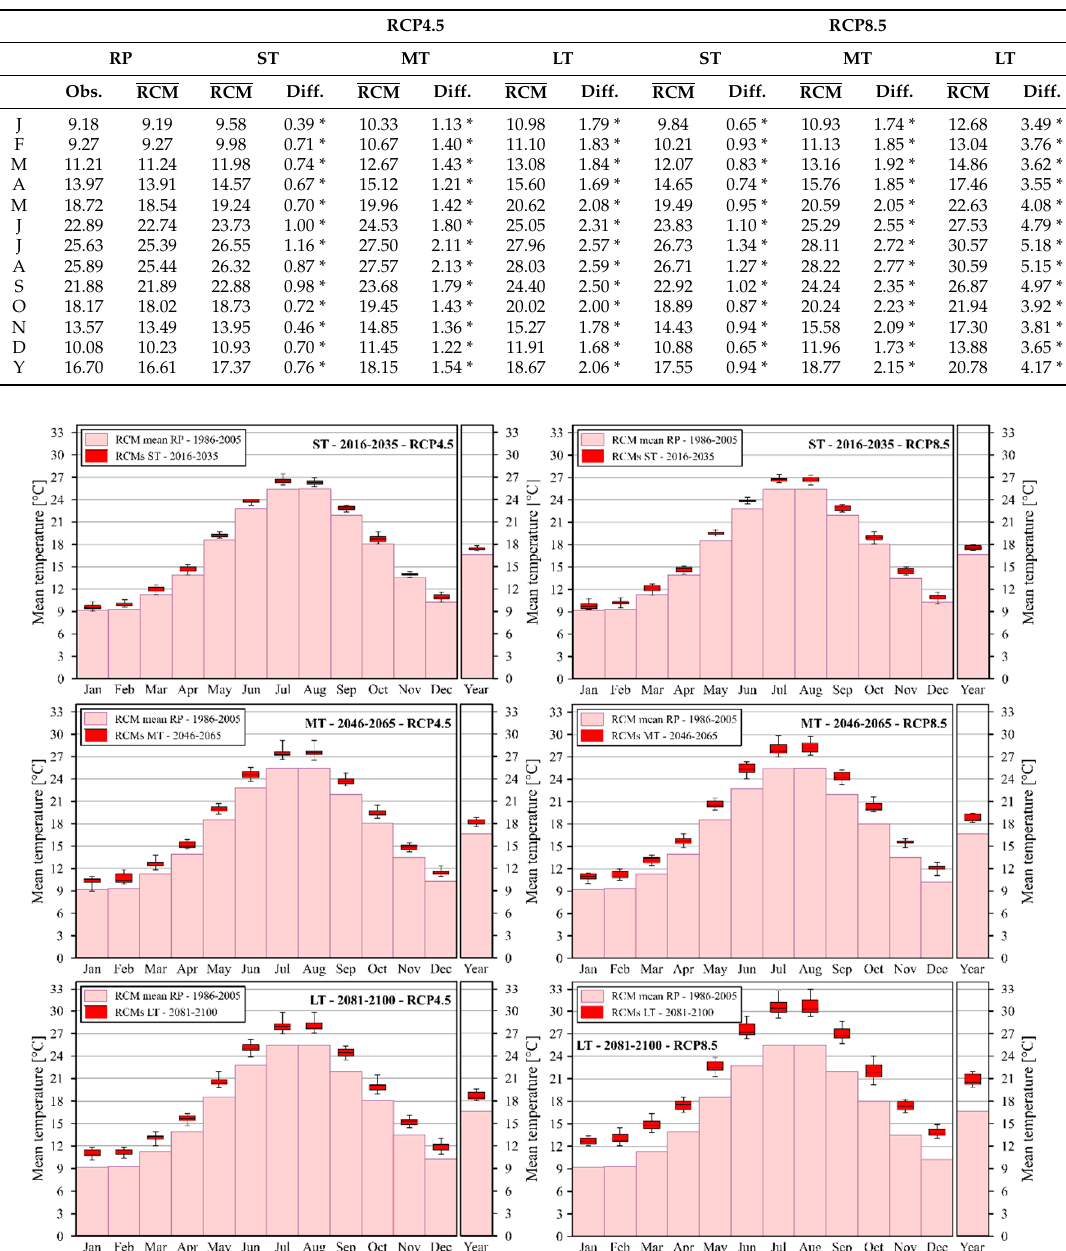
Table 5. Monthly and annual mean temperature, over the whole Salento area, for the reference period (RP, 1986–2005), at the short—(ST, 2016–2035), medium—(MT, 2046–2065) and long-term (LT, 2081–2100). Observed values (Obs., [ ◦ C]), RCM ensemble mean (RCM, [ ◦ C]) under the RCP4.5 and RCP8.5 scenarios and differences (Diff., [ ◦ C]) between the projections at ST, MT, LT and the RP ones; the symbol * means that the change is robust.